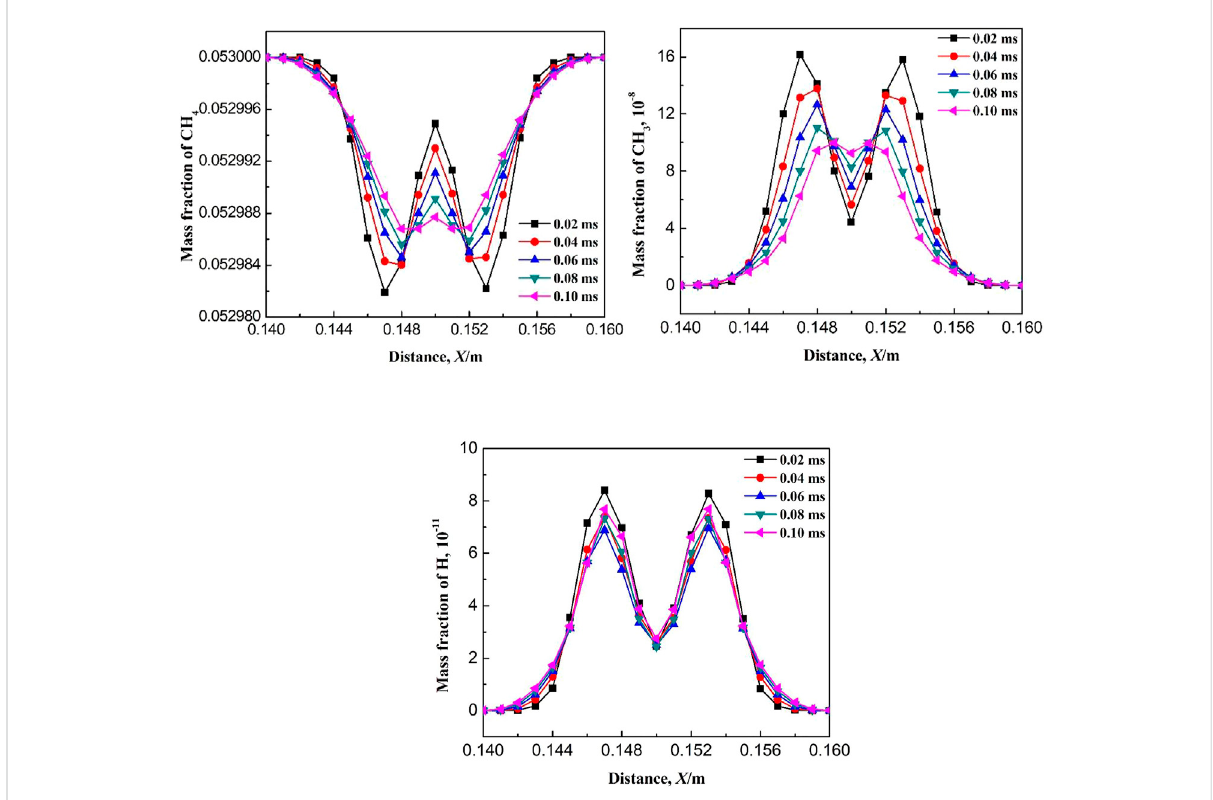
FIGURE 18 Variation of mass fraction of species when ignition temperature is 1170